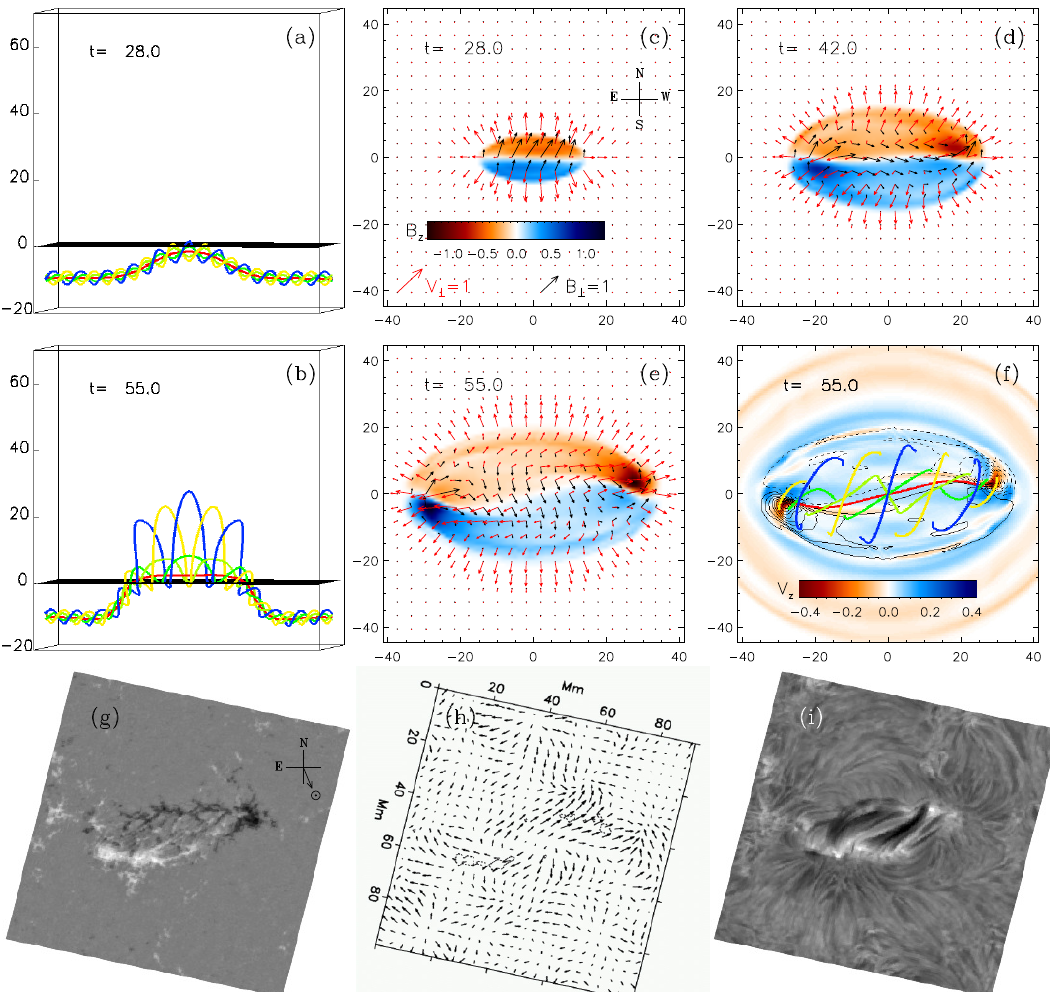
Figure 20: Result of 3D simulation of the emergence of a twisted flux tube. Panels (a) and (b) show magnetic field lines at different times. In both panels, the red line indicates locus of the tube axis, which is seen to be trapped in the photosphere while the peripheral field lines are able to reach the corona. Image reproduced with permission from Fan (2001b), copyright by